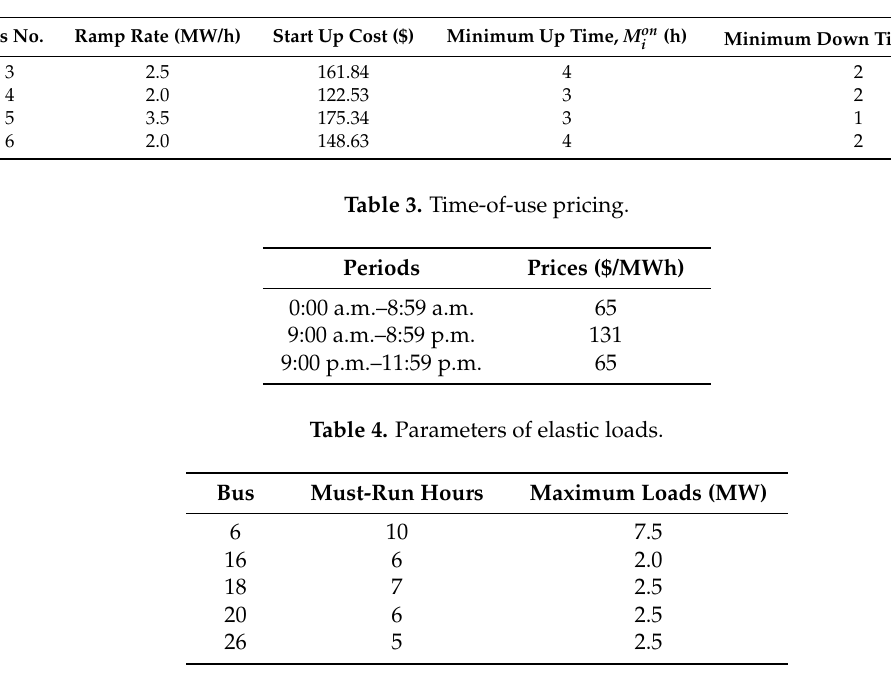
Table 2. Operational parameters of generators.